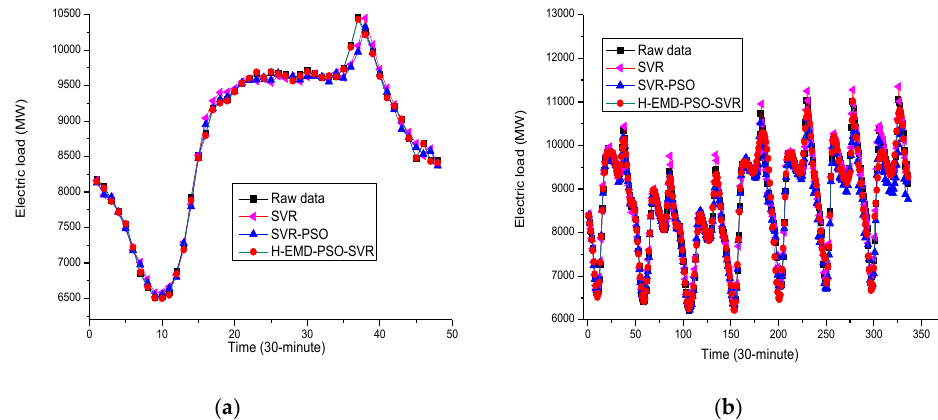
Figure 6. Comparison of the forecasting results among the H-EMD-SVR-PSO model and other models. ( a ) The small sample; ( b ) The large sample.